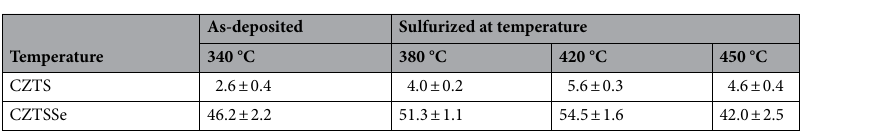
Table 2. The size of CZTS crystallites for as-deposited absorber and after the sulfurization at temperatures of 380, 420, and 450 °C, and also of CZTSSe crystallites after the selenization of above mentioned CZTS absorbers at temperature of 540 °C for 30 min.